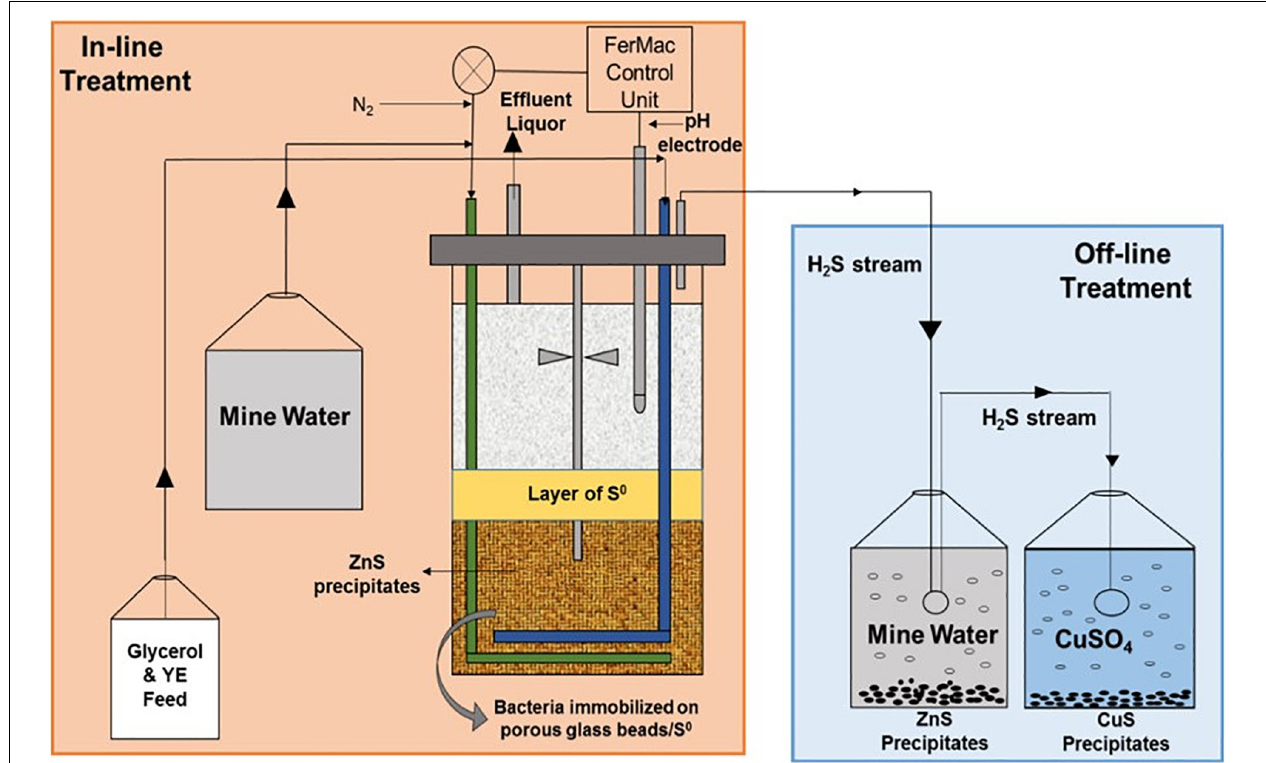
FIGURE 1 | Schematic representation of the set up used to assess removal of soluble zinc from circum-neutral pH, metal-contaminated mine waters.